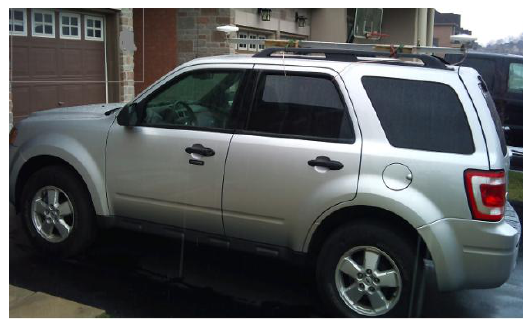
Figure 6. Vehicle snapshot.